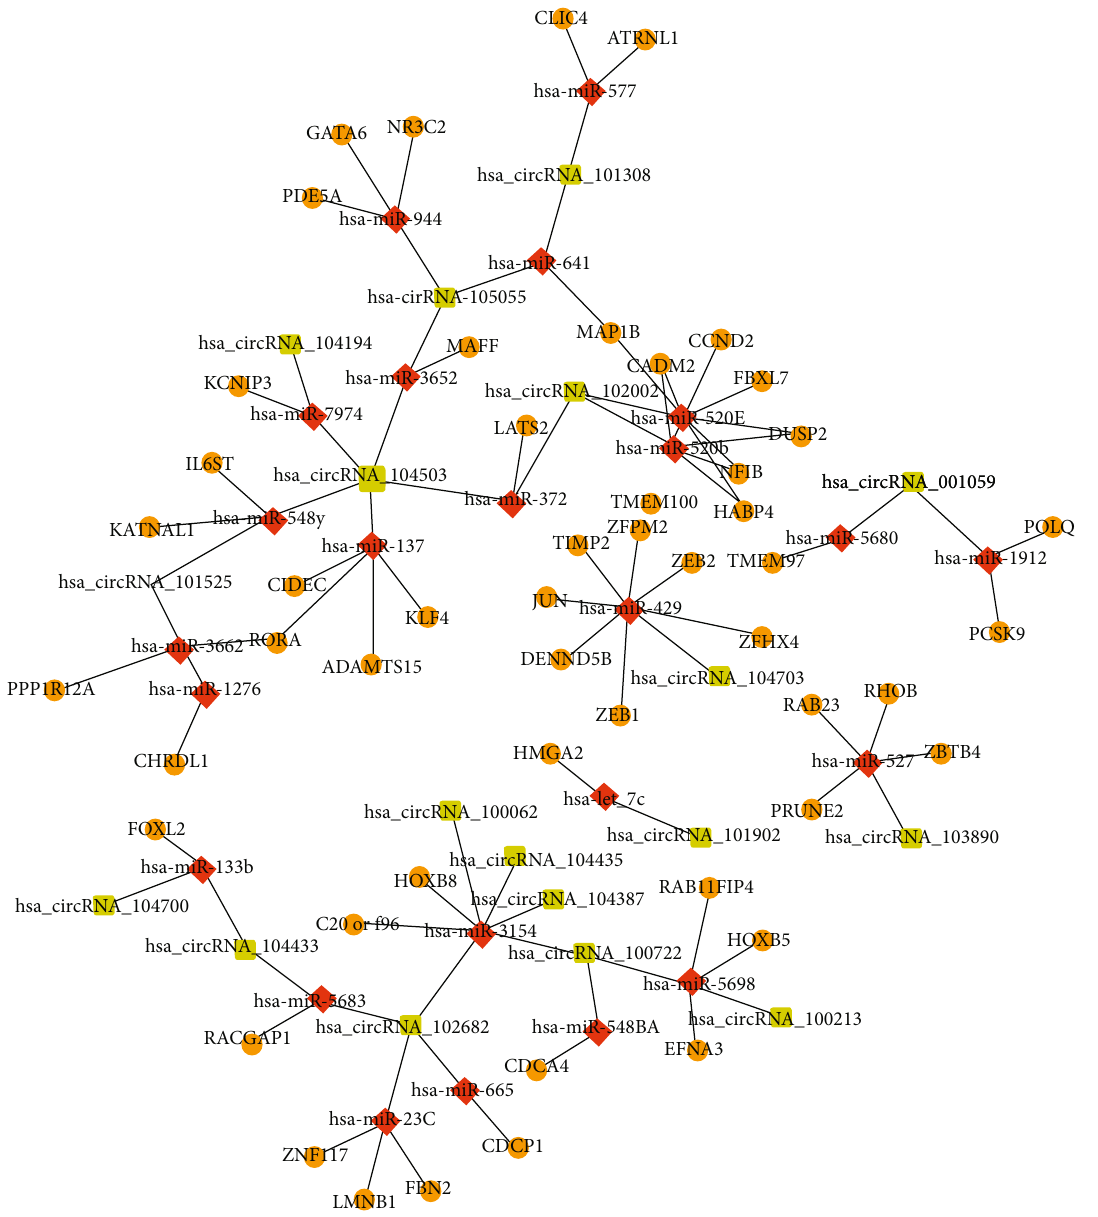
Figure 3: Hub gene identi fi cation from the targeted interaction network of the top 50 DEGs (circRNAs, miRNAs, and